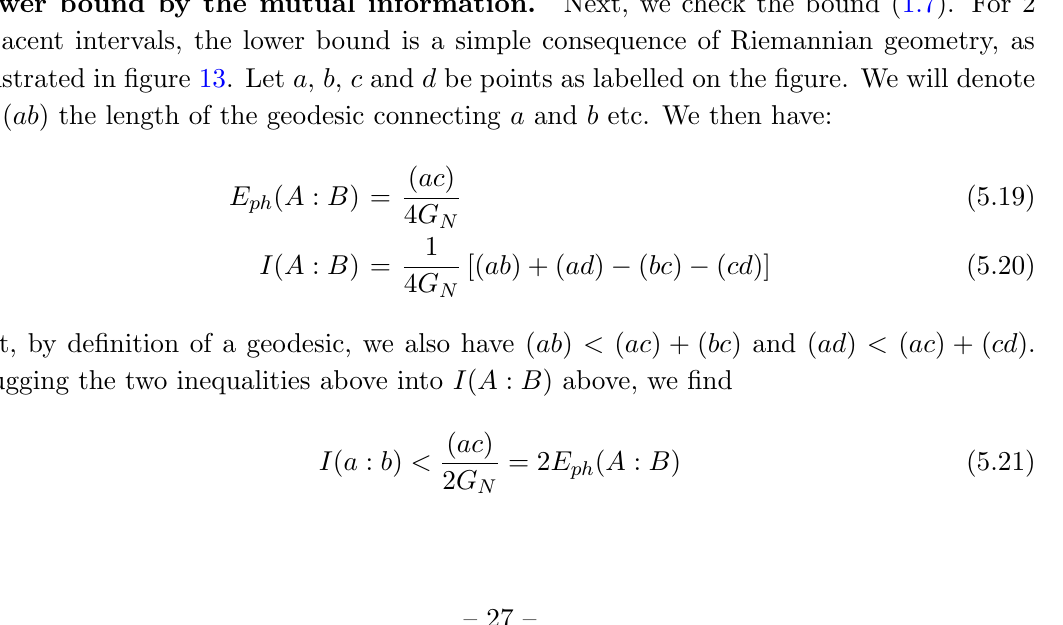
1 I ( A : B ) for two adjacent ph ( A : B ) (cid:21) 2